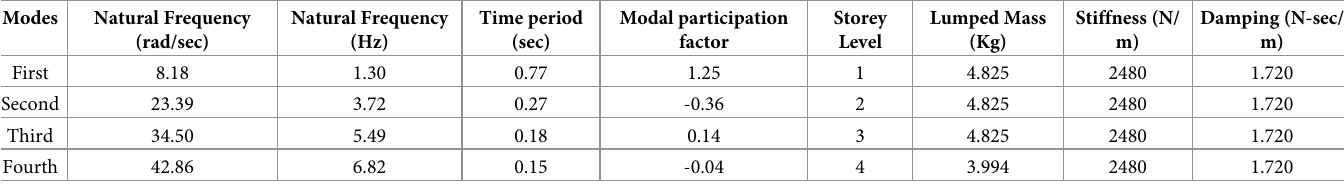
Table 1. Modal properties of steel frame used in experiments. Modes Natural Frequency Natural Frequency (rad/sec)